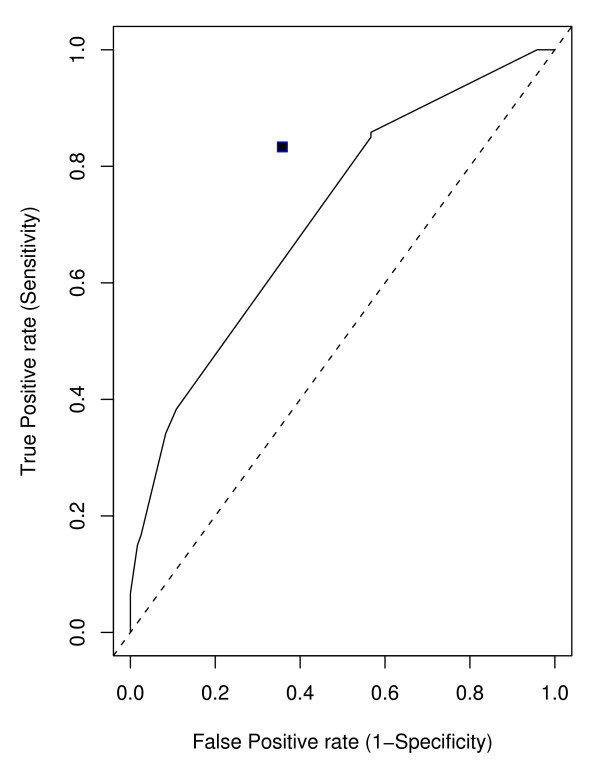
ROC Curve. Receiver operating characteristic (ROC) curves for penalized logistic regression. The value for MDR is represented by a solid square in the plot.